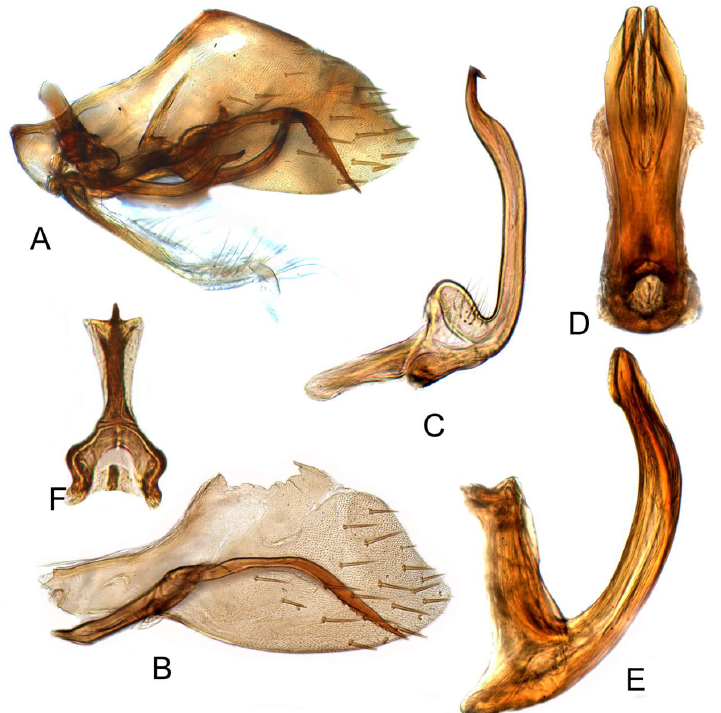
Figure 7. Batracomorphus subfuscus (Li and Wang, 1993): ( A ) genital capsule in lateral view; ( B ) pygofer side and pygophore processes; ( C ) styles; ( D ) aedeagus, ventral view; ( E ) aedeagus, lateral view; ( F ) connective. Material examined. 4 ♂ , Shaanxi, Ningshan, Huoditang Forest Station, 17 – 19.vii.2018, Sun Qihan; 6 ♂ , Shaanxi, Ningshan, Huoditang Forest Station, 18 – 19.vii.2018, Xu ZhiXin; 4 ♂ , Shaanxi, Ningshan, Huoditang Forestry Station, 18.vii.2018, Xu YiFei; 3 ♂ , Shaanxi, Taibai Mountain, Haopingsi, 15.vii.2002, 1170 m, Dai Wu (Figure 1) (NWAFU). Distribution. China (Shaanxi, Henan, Guizhou, Zhejiang). Remarks. This species was described based on one male and two female specimens deposited in the collection of Guizhou University. The illustrations given by Li and Wang (1993) [18] were misleading. Dr. J.C. Xing checked the type specimen and confirmed that the male genitalia illustrated here agree with the male genitalia of the holotype. B. nigro- marginattus was described from Henan by Cai and Shen (1999) [48]. Based on the descrip- tions and illustrations provided by Li and Wang (1993) [18] and Cai and Shen (1999) [48],